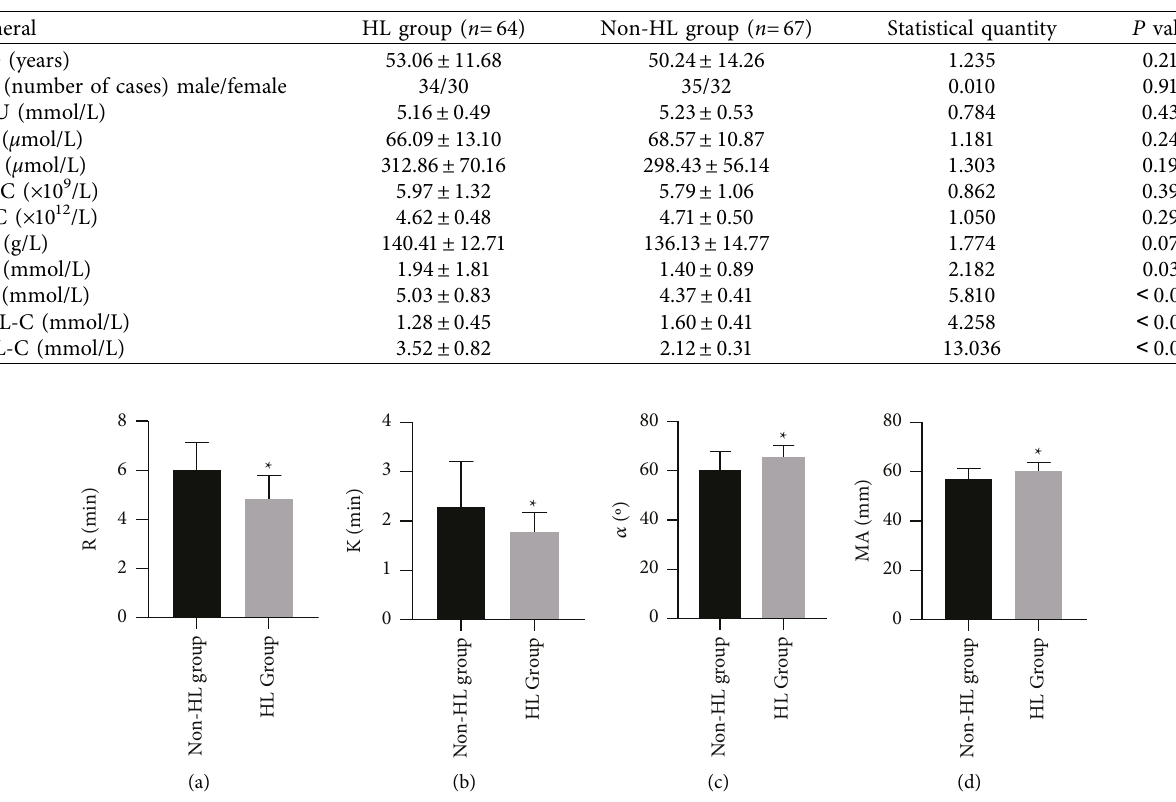
Table 1: General information of patients.